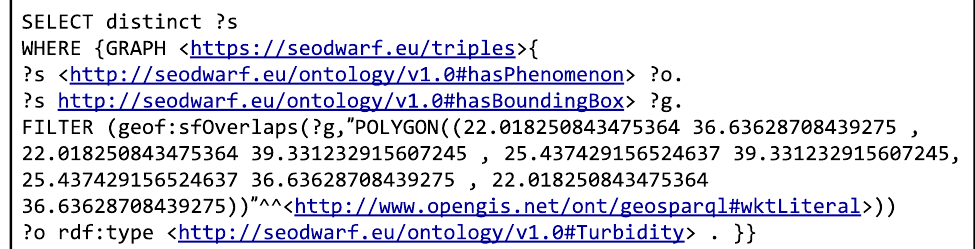
Figure 3. Example of query processed by SeMaRe methodology.